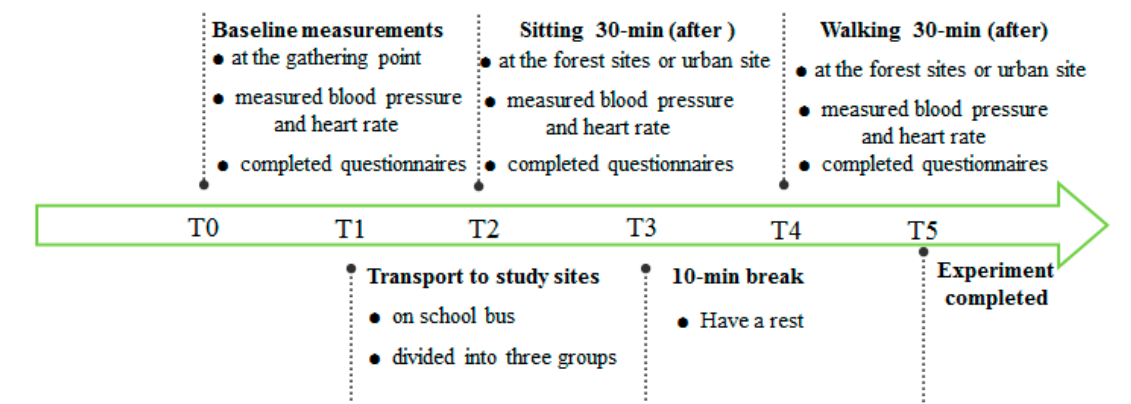
Figure 3. Flow diagram for on-site experimental protocol.